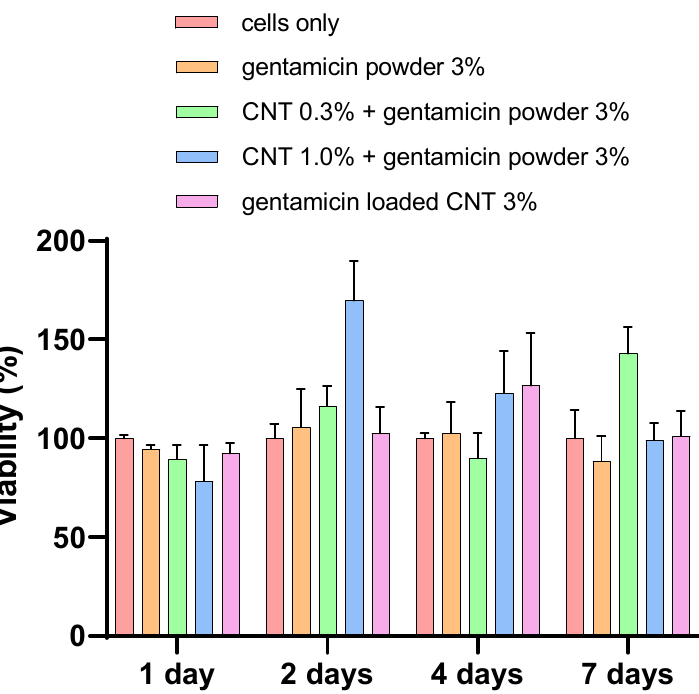
Figure 10. Cytocompatibility test (LDH assay) for osteoblasts with different cements types ( n = 6 ± SD).